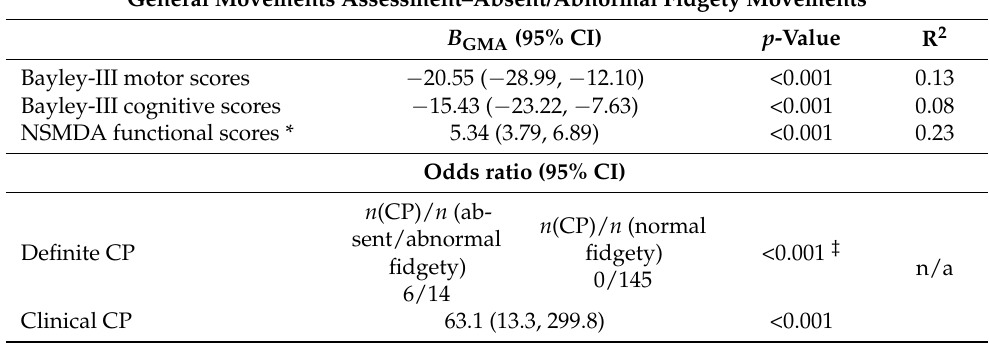
Table 3. Association between absent/abnormal fidgety movements with Bayley-III motor, cognitive scores, NSMDA functional grades, and CP (definite and clinical